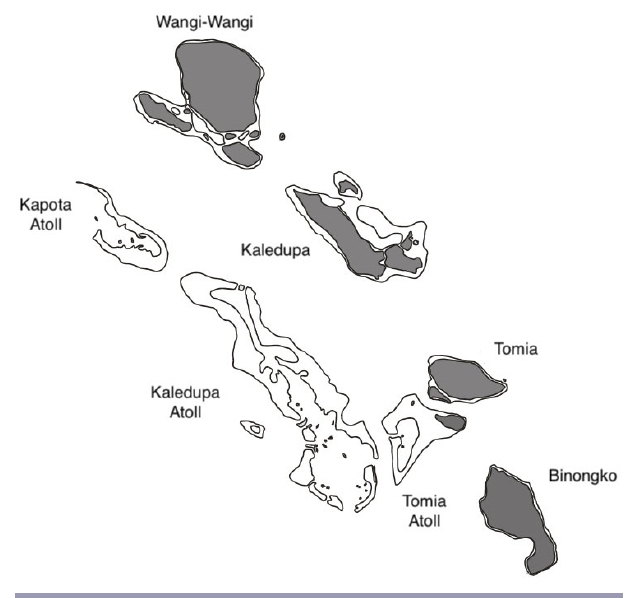
Fig. 1 . Wakatobi National